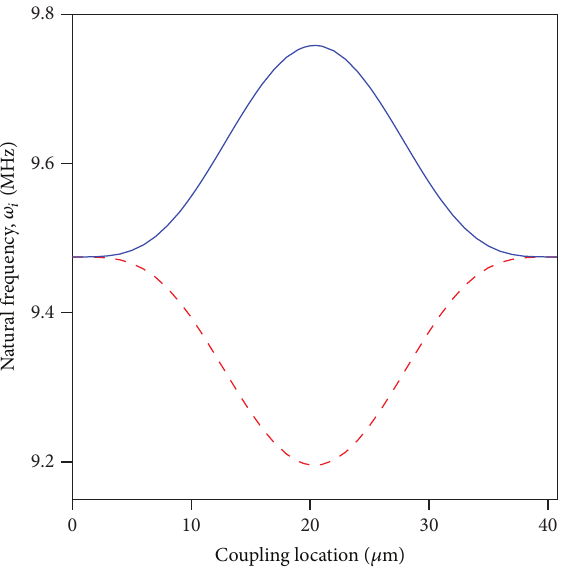
Figure 13: Variation of the center frequency of the unactuated filter with the attachment